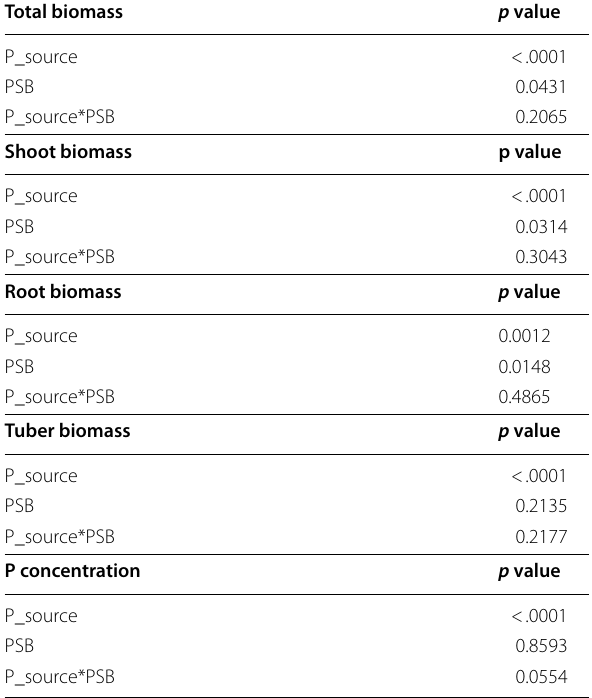
Table 1 Two-way ANOVA for total dry biomass P concentration as well as biomass of the individual plant components (roots, shoots, and tubers)